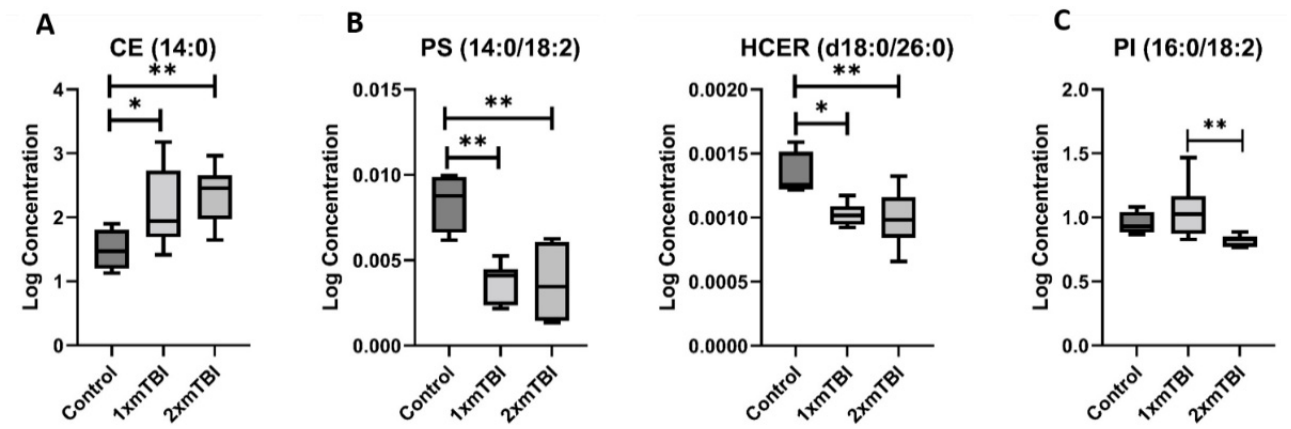
Figure 2. Lipids that change with one and two injuries vs. sham control. ( A ), increase after 1 × or 2 × mTBI; ( B ), decrease after 1 × or 2 × mTBI; ( C ), increase with 1 × mTBI and decrease with 2 × mTBI. Boxplots represent the minimum, first quartile, median, third quartile, and maximum, for the control, 1 × mTBI and 2 × mTBI groups. Significant differences between groups are indicated above the boxplots by * ( p < 0.05) or ** ( p < 0.01). CE, cholesterol ester; HCER, hexosylceramide; mTBI, mild